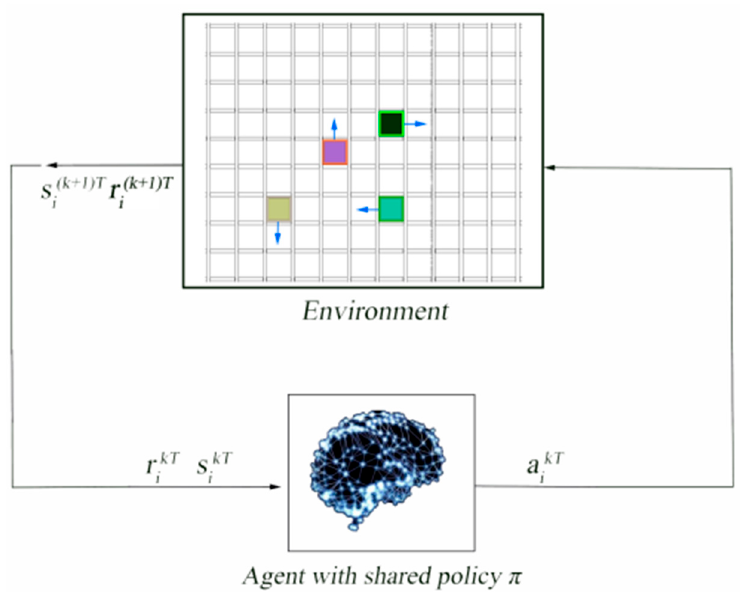
Figure 4. Overview of the process of data collection. At time kT , the i -th robot performed the action a ikT generated according to the policy π in state s ikT . Algorithm 1: DQN with Multiple Robots in Grid Map